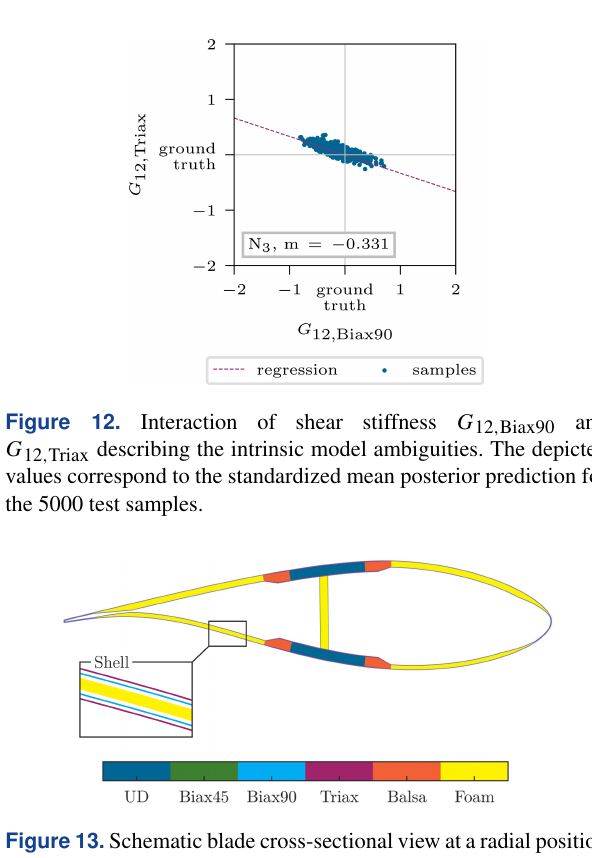
Figure 13. Schematic blade cross-sectional view at a radial position of r = 12m with a detailed explosion drawing of the